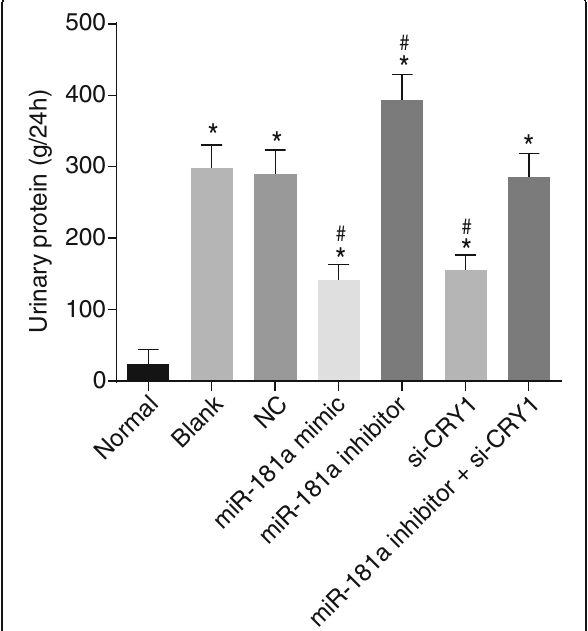
Fig. 2 Bar graph shows the 24-h urinary protein level at the end of the 4th week after transfection in each group, demonstrating that up- regulated miR-181a or down-regulated CRY1 leads to the reduction of urinary protein levels in CKD. Notes: * , p <0.05 vs. the normal group; # , p <0.05 vs. the blank and NC groups; the data are presented as the mean±standard deviation, analyzed by one-way ANOVA; the experiment was independently repeated three times; CRY1, cryptochrome 1; miR-181a, microRNA-181a; CKD, chronic kidney disease; NC, negative